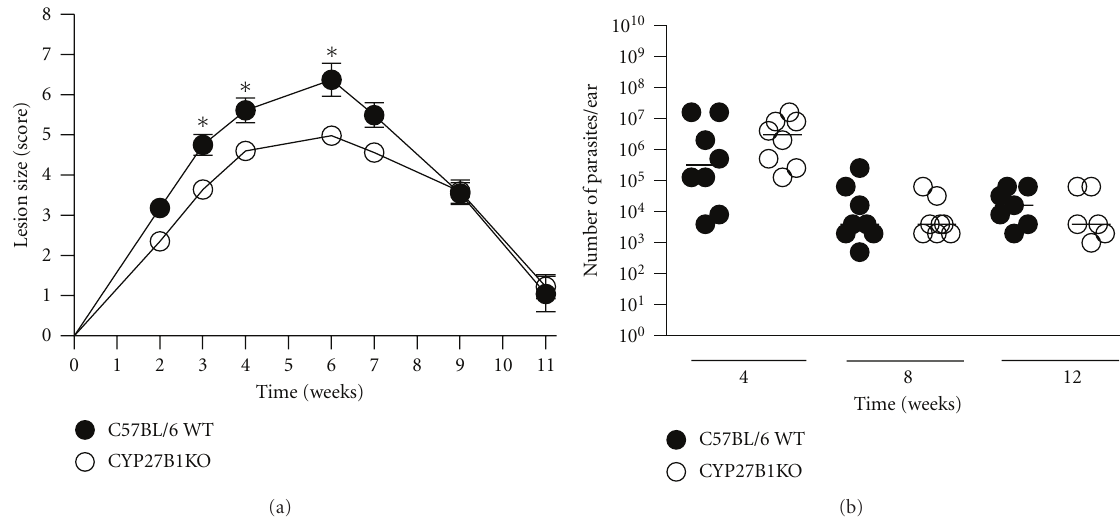
Figure 2: Lesion size is reduced in CYP27B1KO mice. C57BL/6 WT (closed circles) and CYP27B1KO (open circles) mice were infected with 10 5 L. major parasites and the resulting lesions were measured at the indicated time points. Mean ± SE is presented; n = (8–17). (b) Infected ears were harvested at 4, 8, and 12 weeks after infection, and parasite load was determined by limiting dilution assay. Each point indicates parasite burden in one ear. One representative of two independent experiments is presented. ∗ P ≤ 0 . 05.